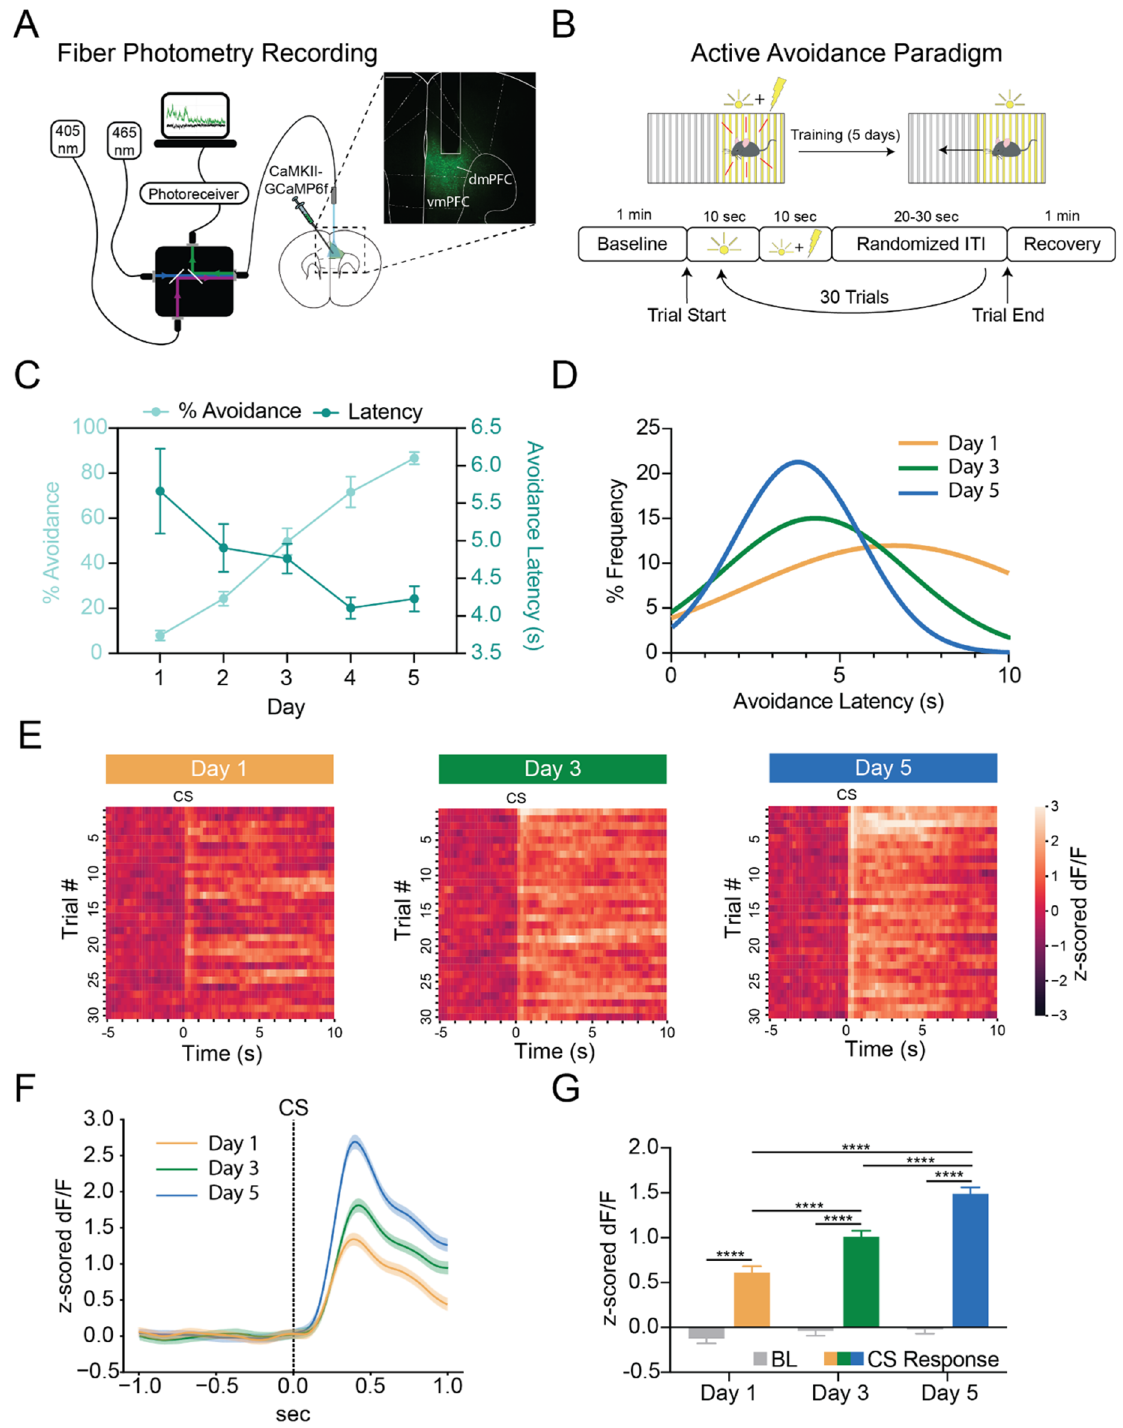
Figure 1. dmPFC shows learning-related increases in activity at CS onset during active avoidance learning. ( A ) Fiber photometry recording of dmPFC pyramidal neurons expressing GCAMP along with a representative histological image of GCAMP viral expression in the dmPFC. Scale bar 500 µm. ( B ) Behavioral schematic for active avoidance paradigm. ( C ) Average percent successful avoidance increased while avoidance latency decreased across training days. ( D ) Avoidance latency distribution shows avoidance latencies become shorter and more stereotyped across training. ( E ) Heatmaps of average change in calcium signal (z-scored dF/F) for each of the 30 trials presented in order from the first to the last trial for Day 1 (left), Day 3 (middle), and Day 5 (right). Heatmaps are aligned to CS onset (time zero) and show the total 10 s CS only period. dmPFC shows increased calcium signal at CS onset that becomes more consistent and sustained with training. ( F ) Perievent time histogram (PETH) showing increases in dmPFC calcium signal following CS onset. Orange line, mean ± standard error of the mean (SEM) for Day 1; green line, mean ± SEM for Day 3; blue line, mean ± SEM for Day 5. ( G ) Quantification of CS onset PETH shows calcium signal is significantly higher during the CS period (0 to 1 s) compared to the baseline period (−1 to 0 s) for all days. **** p <